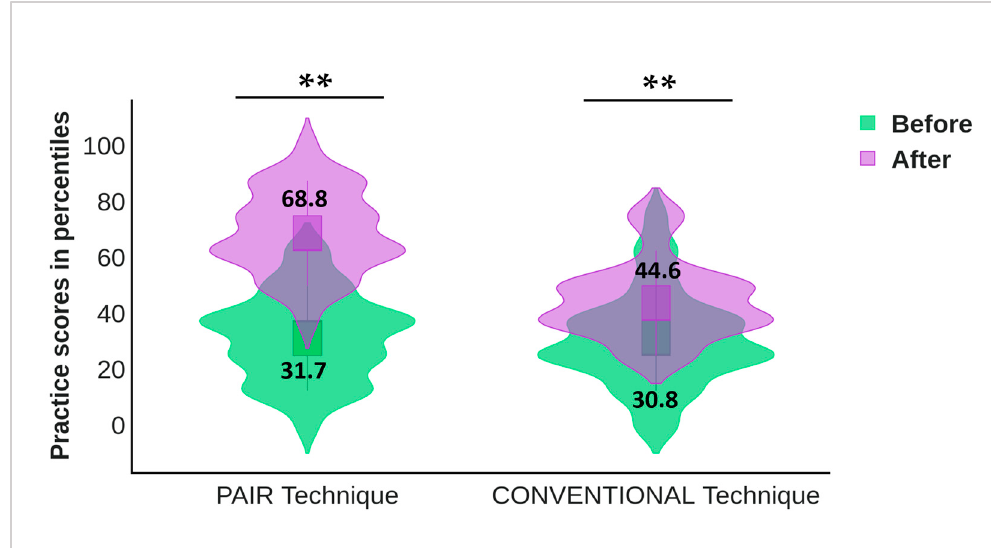
Figure 5. Comparison of practice scores in PAIR group and Conventional group; practice score indicators: unhealthy ( ≤ 50th percentile) and healthy (>50th percentile). Baseline and post intervention practice score in both groups has been represented by violin plot. Statistical test used: Paired t -test. Level of significance: ** p ≤ 0.001 is considered highly statistically significant.